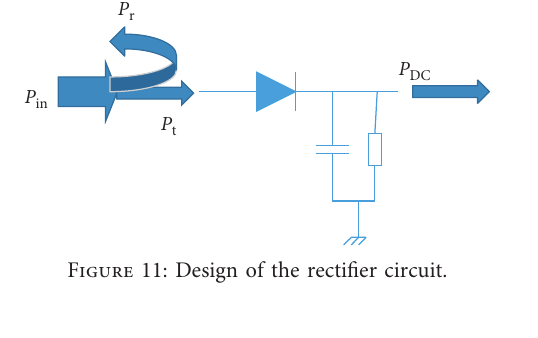
Figure 11: Design of the rectifier circuit.